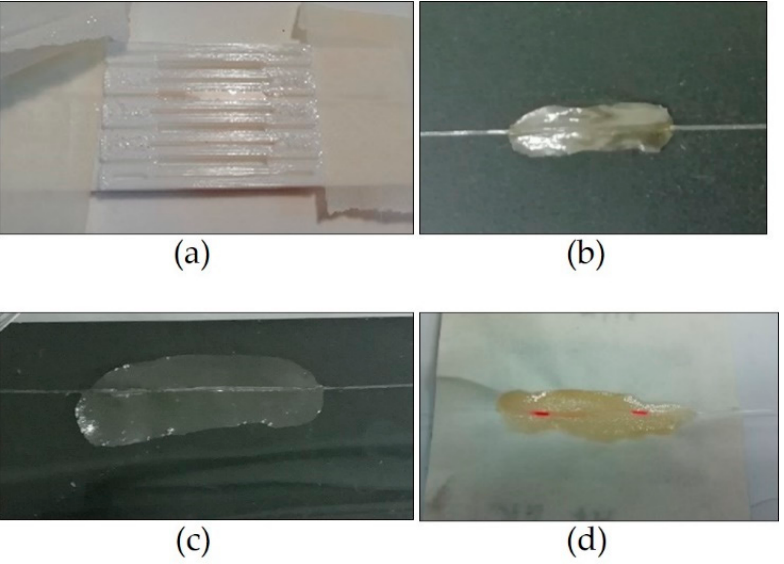
Figure 3. Photos of four samples. ( a ) FBG-PLA in the mould; ( b ) FBG-ACET detached from the acetate sheet; ( c ) FBG-PVC on the PVC layer; ( d ) FBG-FP on the filter paper.